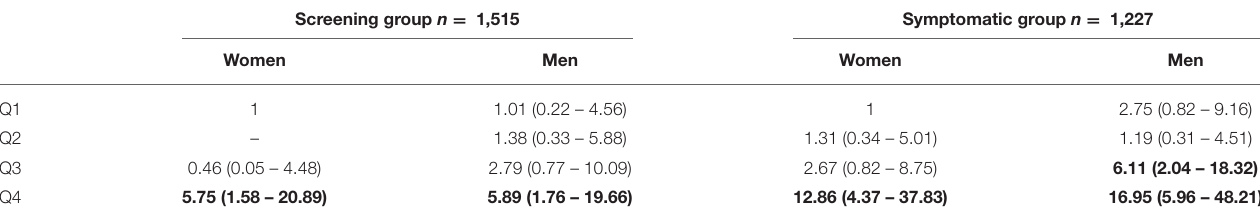
TABLE 5B | Risk of colorectal cancer according to sex and hemoglobin quartile. Screening group n =